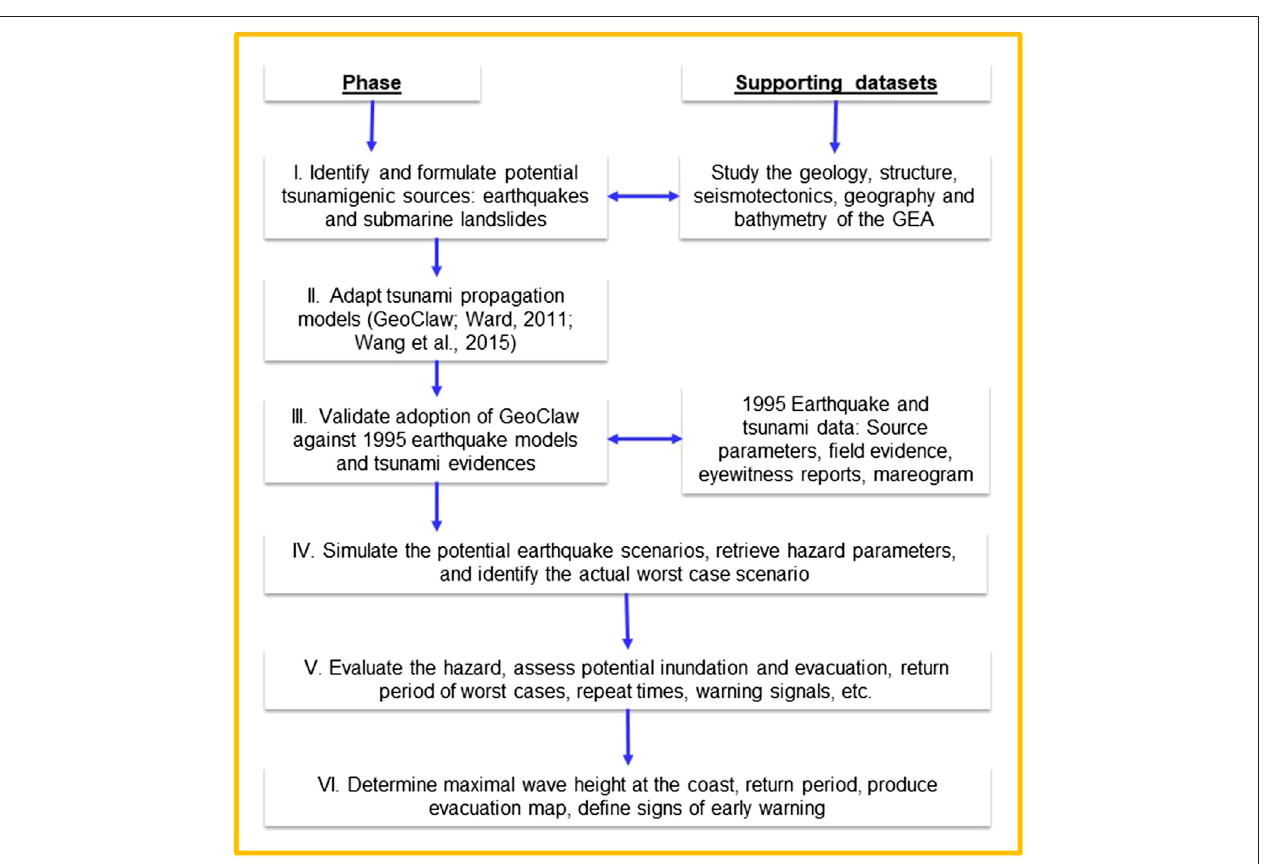
FIGURE 2 | Work plan and phases of the research. The hazard assessment focused on the Israeli coast of the head of the Gulf of Elat – Aqaba (HGEA).